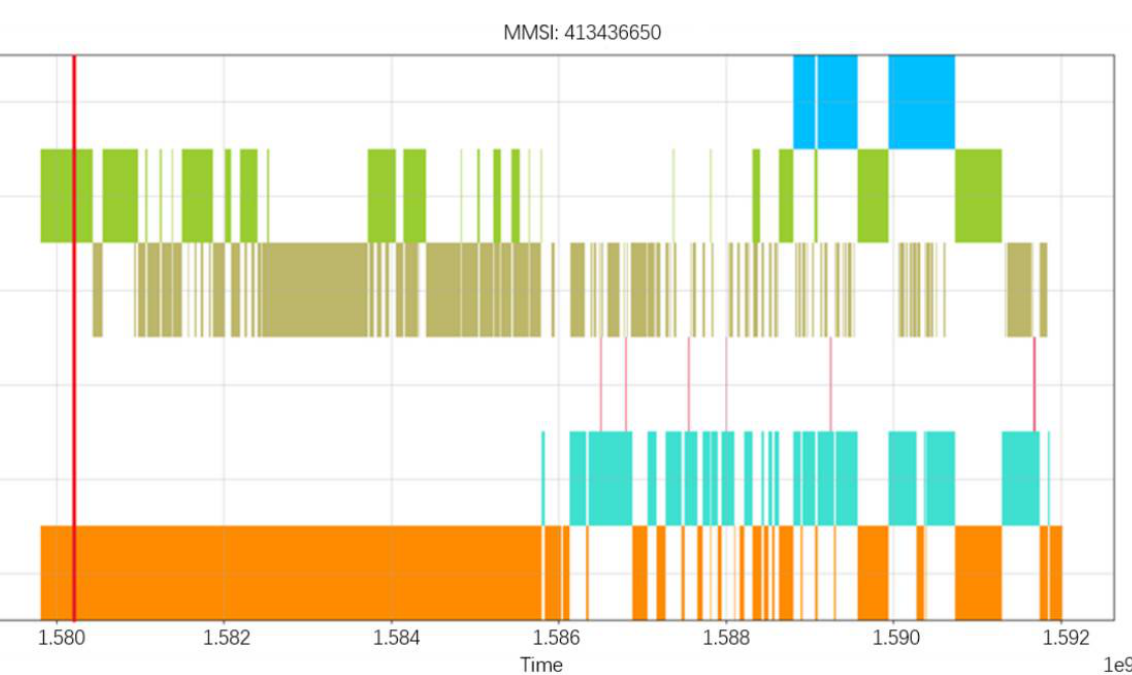
Table 3. Smuggling ship static information table .